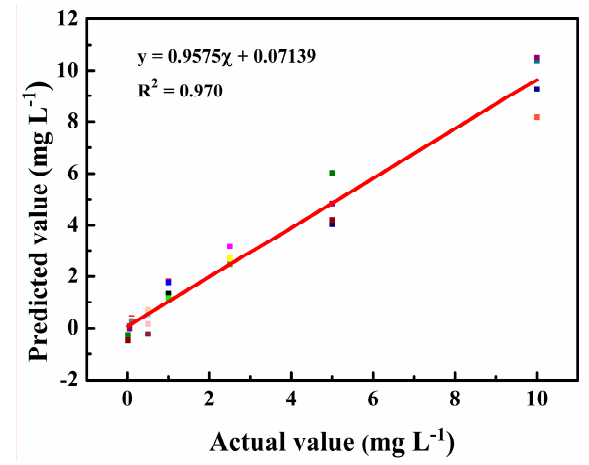
Figure 4. Partial least square (PLS) model of the standard tartrazine solution.